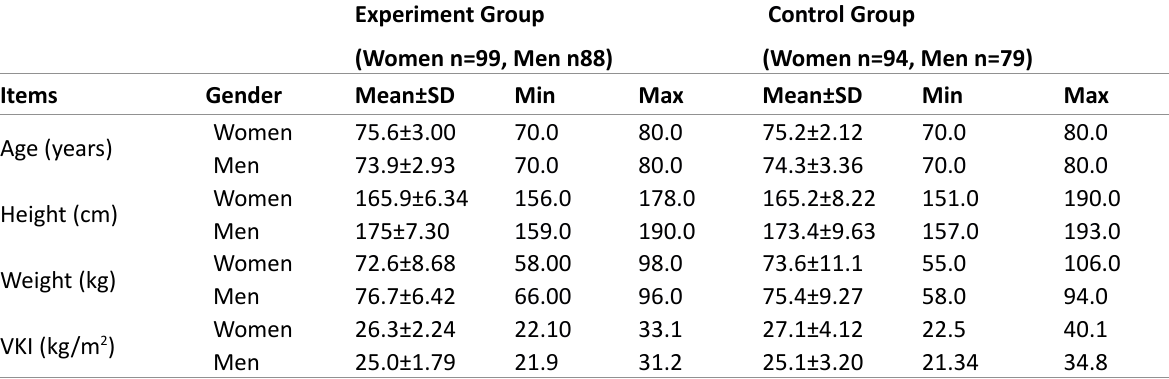
Table 1. Mean, standard deviation, minimum, and maximum height, weight, age, and BMI values of participants in experiment and control groups